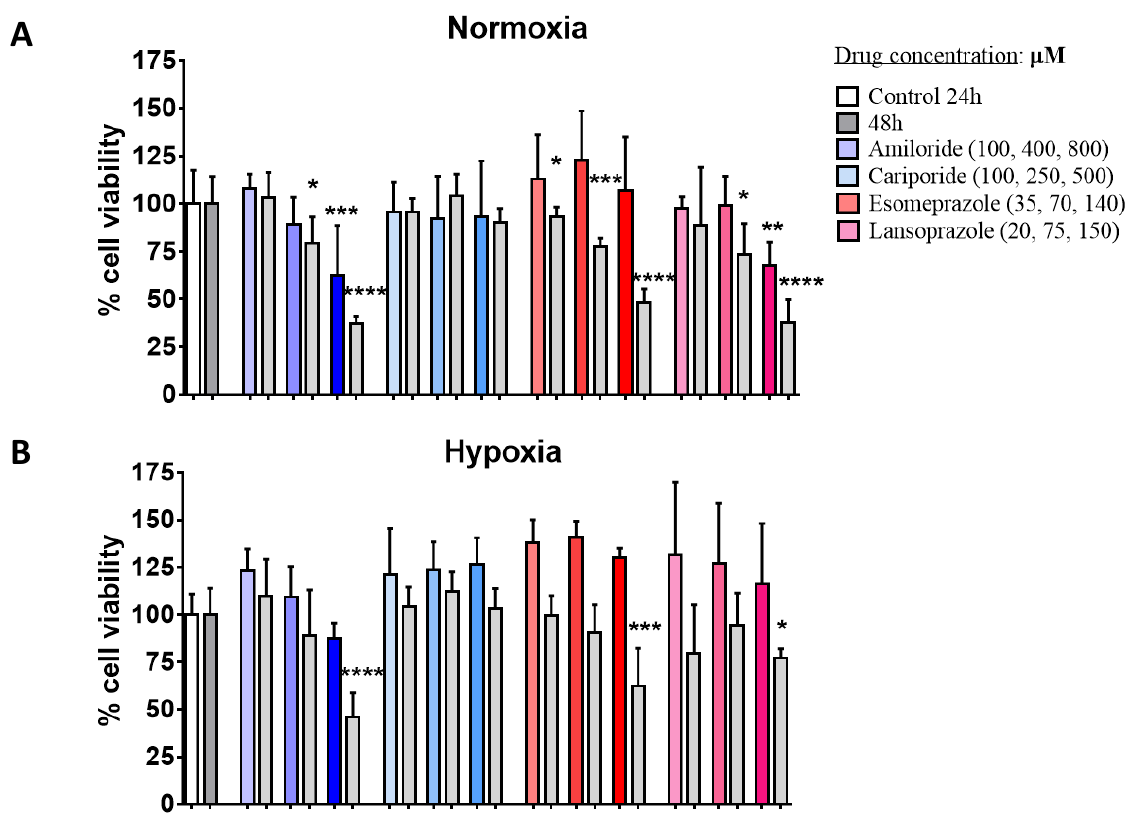
Figure 1. Impact of proton pump inhibitors on cell viability. Cell viability results for DU145 human prostate cancer cell line in normoxia ( A ) and hypoxia ( B ) after 24 or 48 h incubation (gray columns) with Amiloride, Cariporide, Esomeprazole, and Lansoprazole (in blue, light-blue, orange and pink bars, respectively), at increasing concentrations (associated with darker colors of the bar columns; first two columns on the left are control cells at 24h or at 48h). Statistical significance was calculated